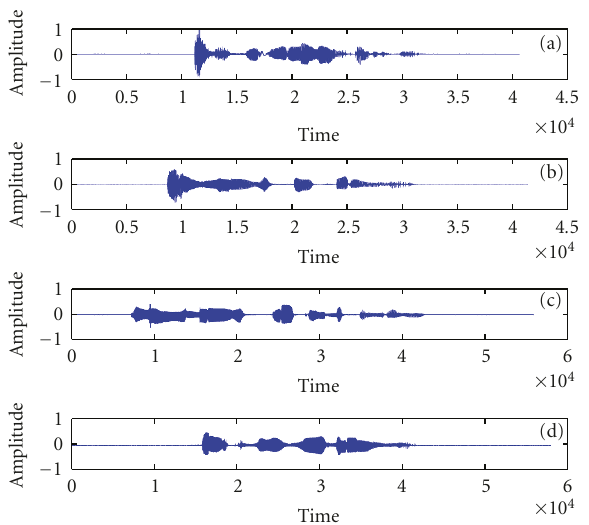
Figure 1: The original signals “a”, “b”, “c”, and “d”.